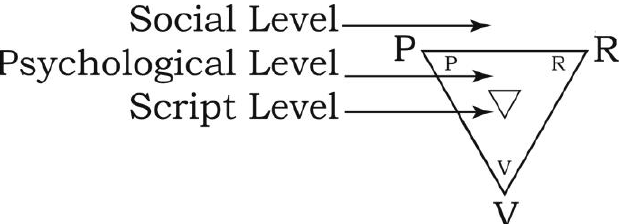
The Talking Level TA Teaching Diagram